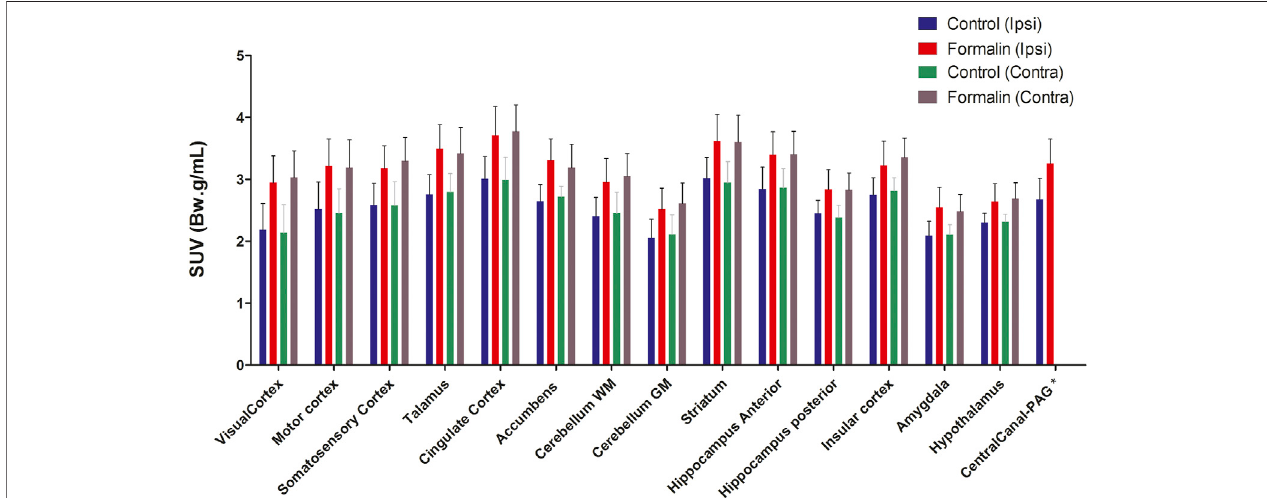
FIGURE3| Differentialuptakeof 18 F-FDGinbrainareasassociatedtoformalin-inducednociceptivestimulus.Thedifferentbrainareas arepresentedbellow x axis. The de fi nition of contra or ipsilateral was made in reference to the right paw where formalin or PBS was administered. Bars represent mean+S.E.M. of the S.U.V. values (N (cid:1) 4 and N (cid:1) 6, PBS and formalin groups, respectively) (N (cid:1) 4 and N (cid:1) 6, PBS and formalin groups, respectively. Repeated-measures ANOVAs with Fisher ’ s post hoc tests). WM, white mater; GM Gy mater; PAG periaqueductal gray.